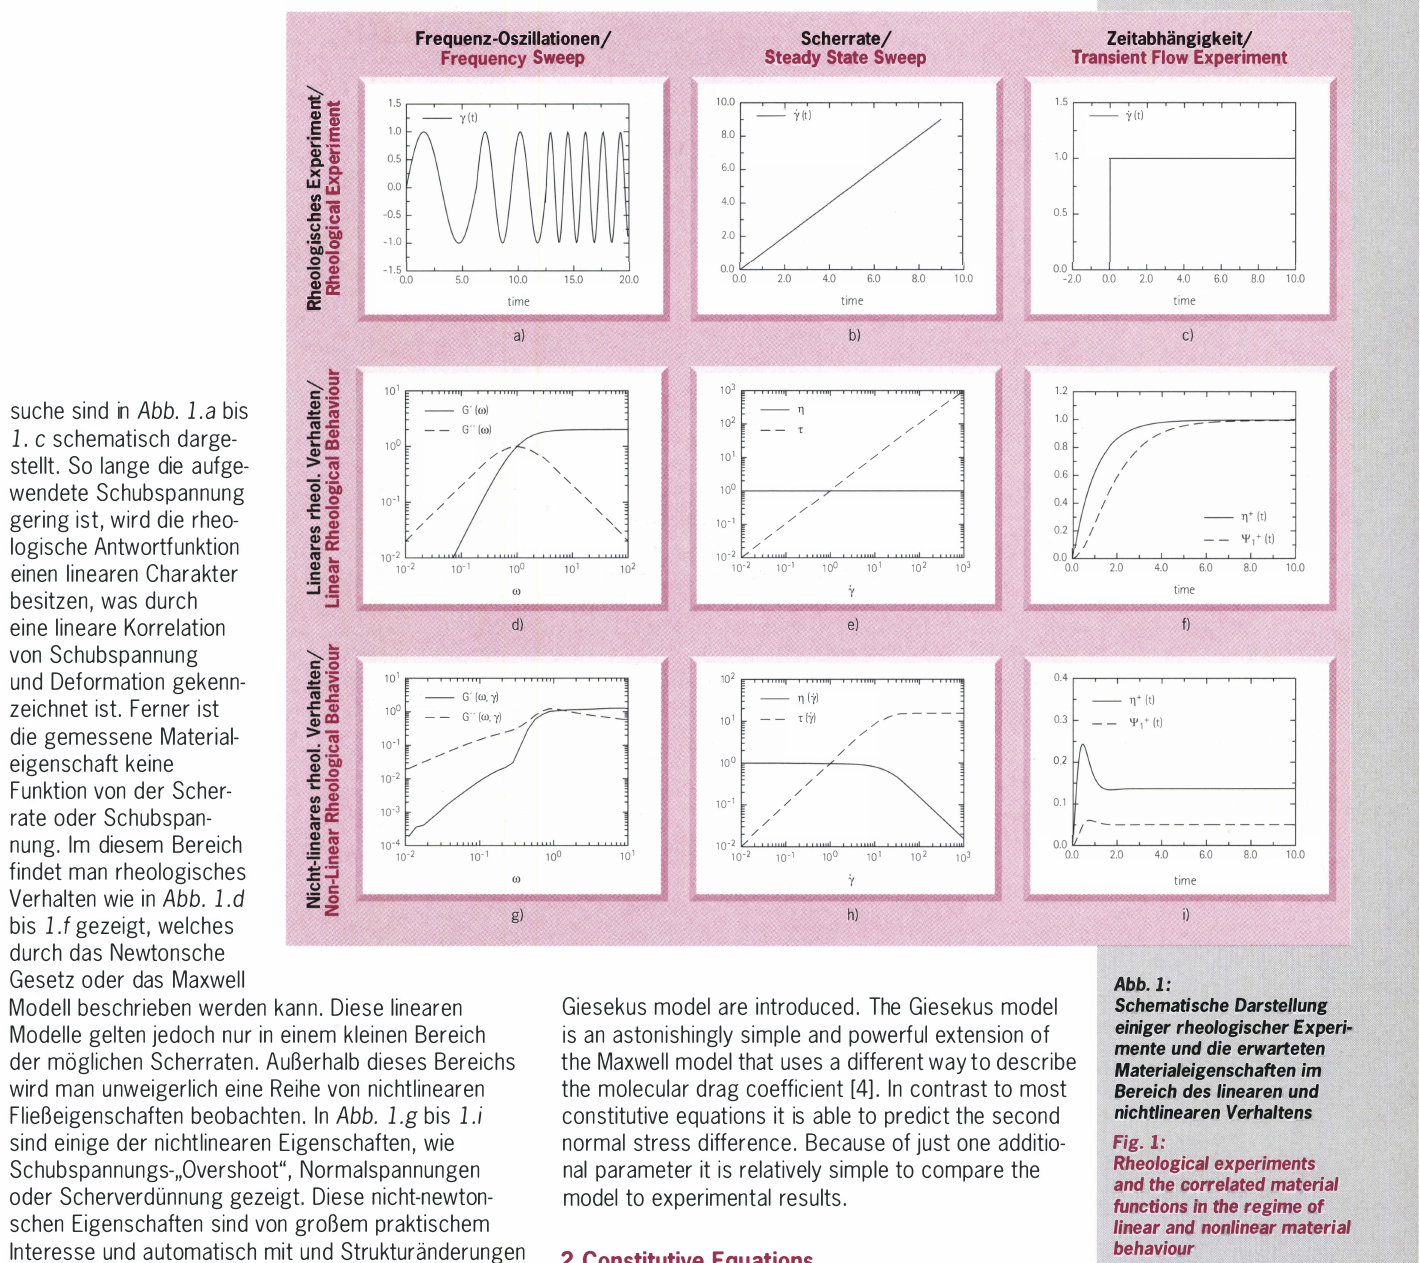
Abb.l: Schematische Darste/lung